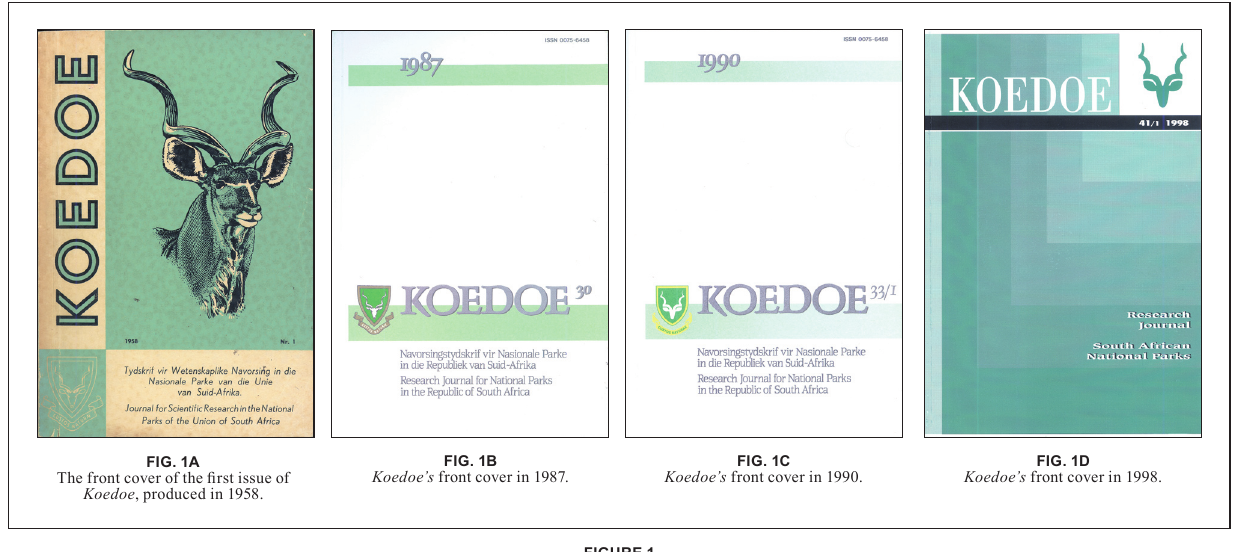
Figure 1 Koedoe covers from 1958 to